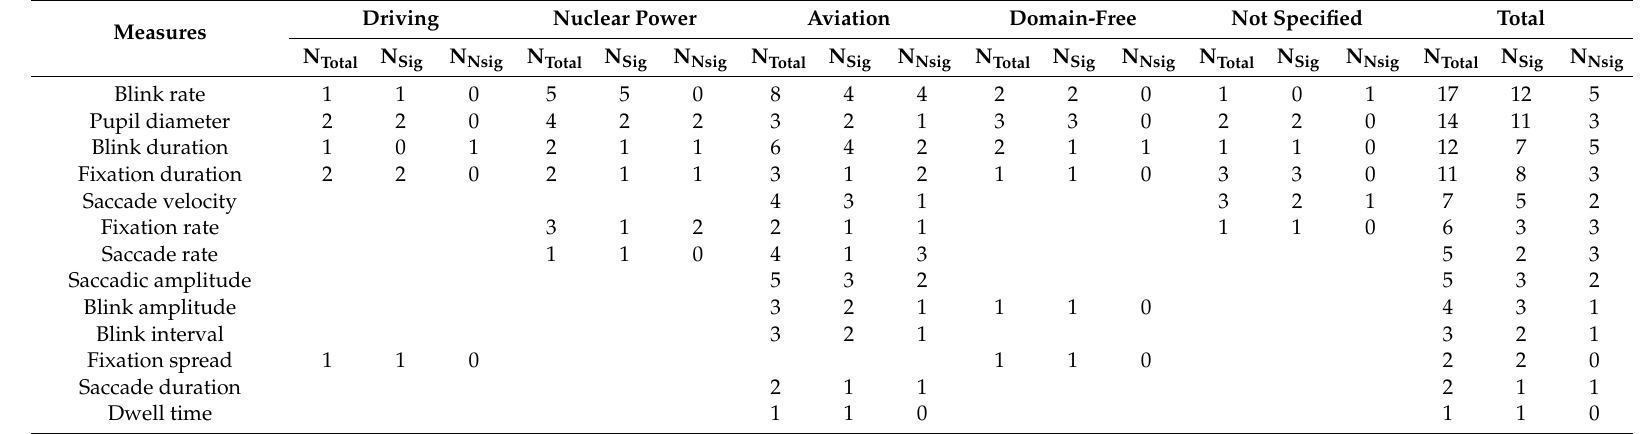
Table 5. Summary of eye movement measures and their statistical significance reported in the reviewed